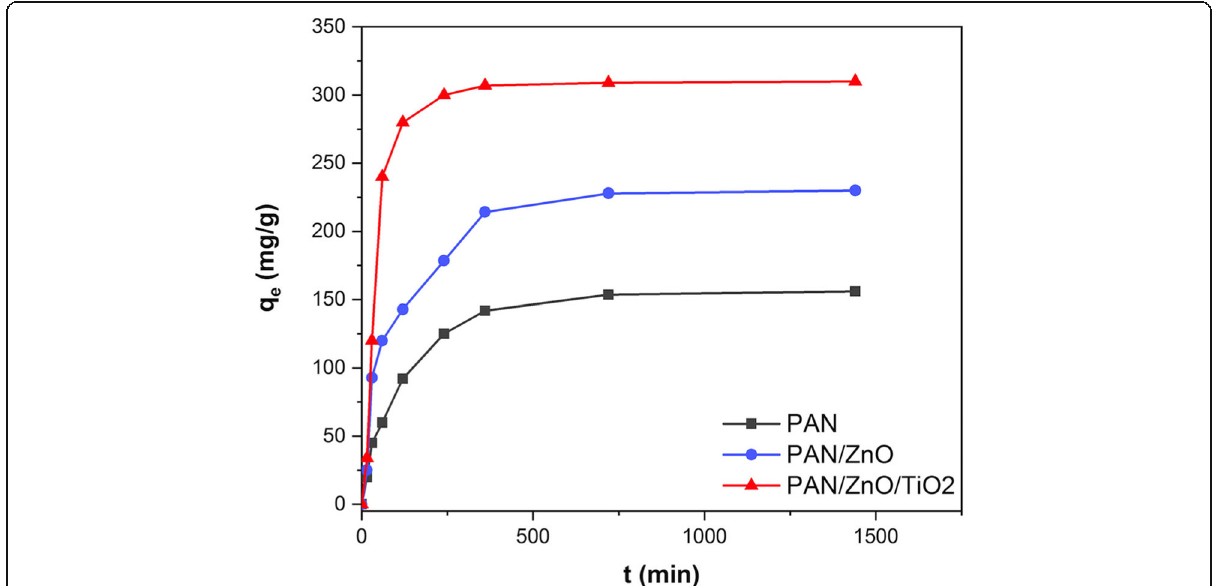
Fig. 9 Effect of contact time on the adsorption of Cr (VI) by PAN based n- fib@Mats